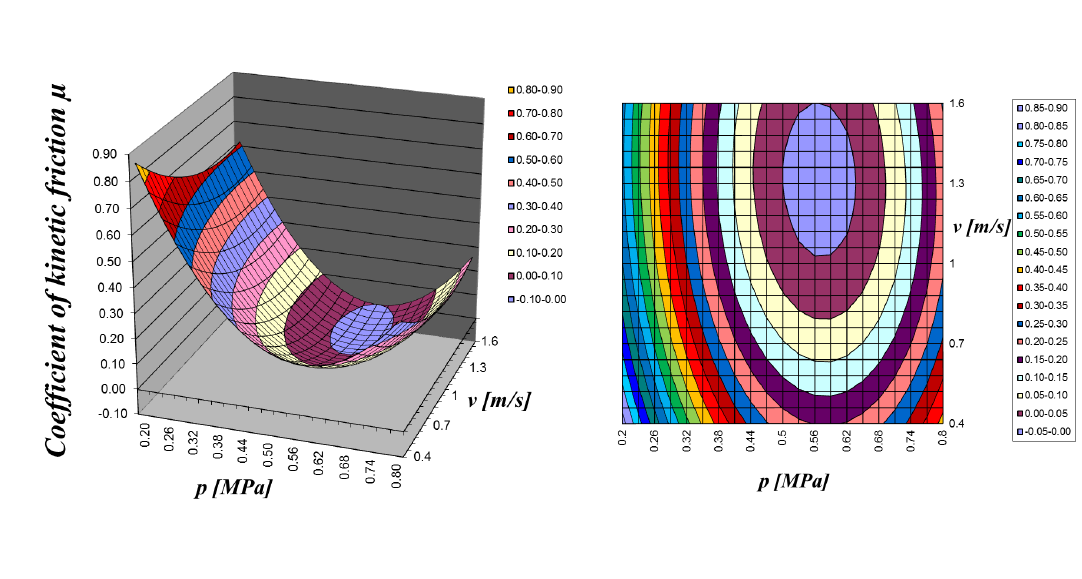
Figure 3: Coeflcient of friction of EPUR with hardness of 80 ∘ Sh A after steel dampened with water depending on the pressure p and sliding speed v